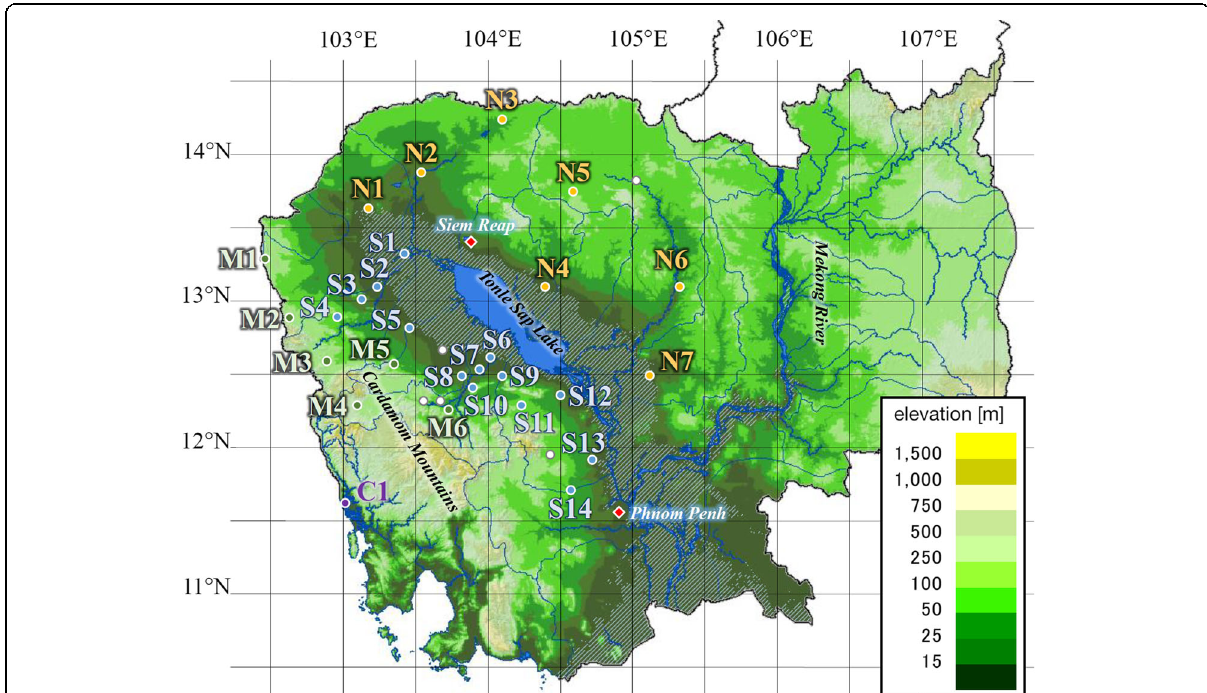
Fig. 2 Map of Cambodia and location of rain gauges with their symbols (N1 – N7 in yellow for northern stations, S1 – S14 in blue for southern stations, M1 – M6 in green for mountainous stations, and C1 in purple for the coastal station). Four white circles show the excluded stations for the analysis due to frequent missing data. Station S7 is equipped with an AWS. The color shades indicate the elevation, and the white hatched area around the Tonle Sap Lake is its seasonal expansion area where it is under water from the middle of the rainy season (around August) to the beginning of the dry season (around December). The base map is adapted from The Atlas of Cambodia (Save Cambodia ’ s Wildlife